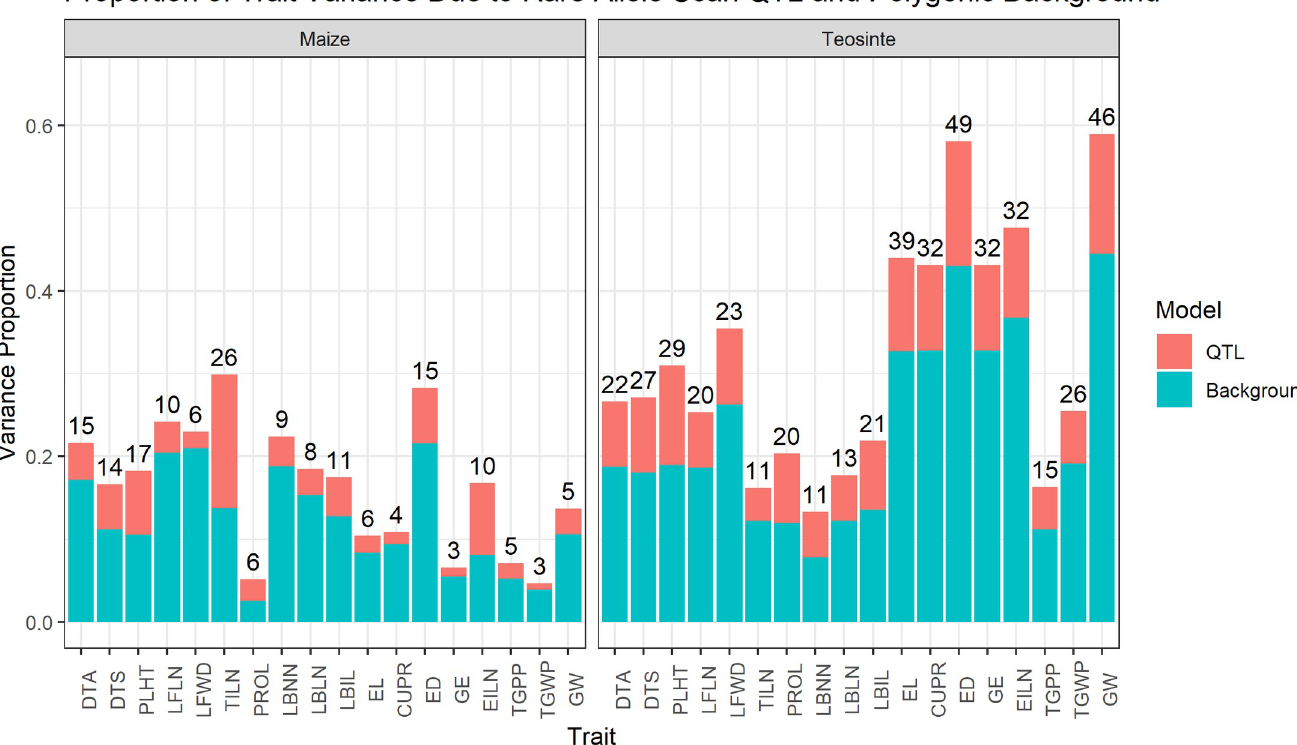
Fig 6. The proportion of trait variance due to rare allele scan QTL (red color) and polygenic background effects (blue color) for each of 18 traits measured in maize and teosinte populations. The number of rare allele scan QTL detected for each population and trait is indicated on top of